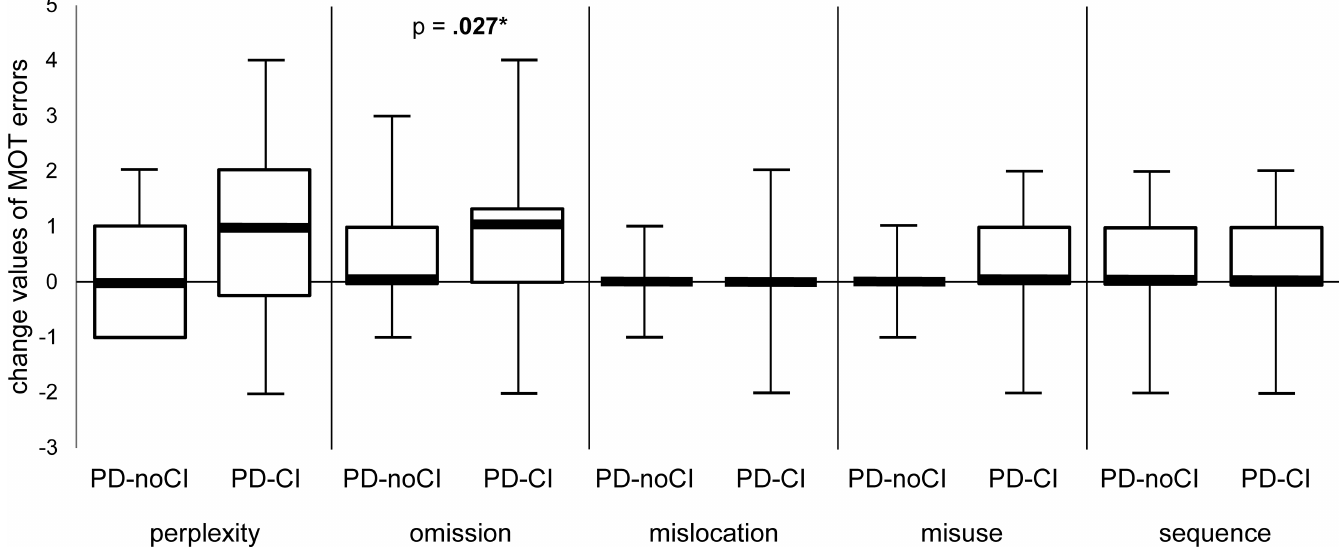
Fig 1. Progression of qualitative MOT parameters. Comparison of change values (follow-up–baseline) in each Multiple Object Test (MOT) error category between PD patients with (PD-CI) and without (PD-noCI) cognitive impairment.